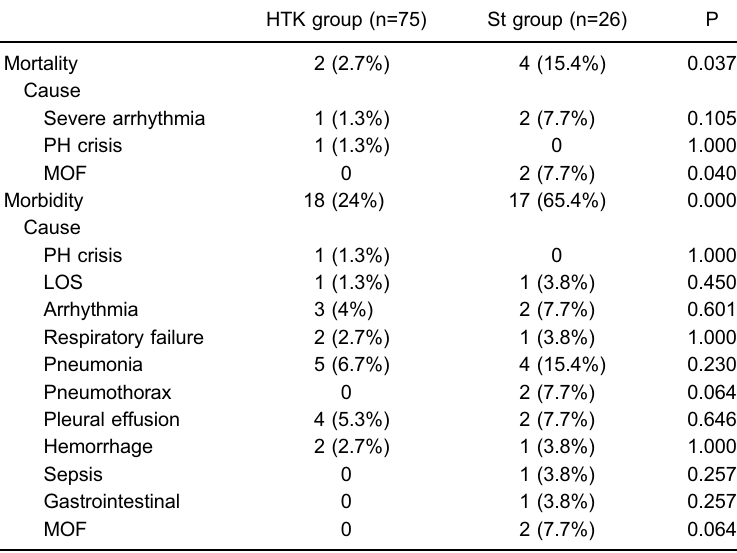
Table 3. Hospital mortality and morbidity of patients who underwent cardiac surgery with histidine-tryptophan-ketoglutarate (HTK) and St. Thomas ’ (St) cardioplegic